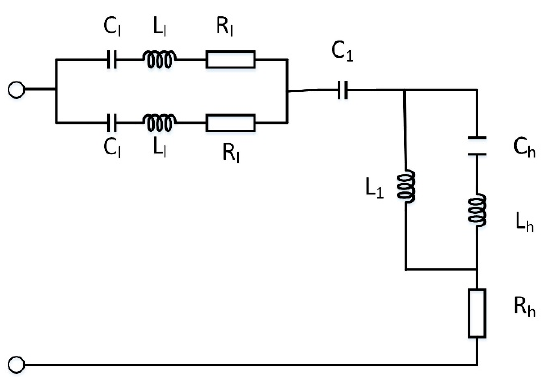
Table 1. Lumped parameters of ECM.